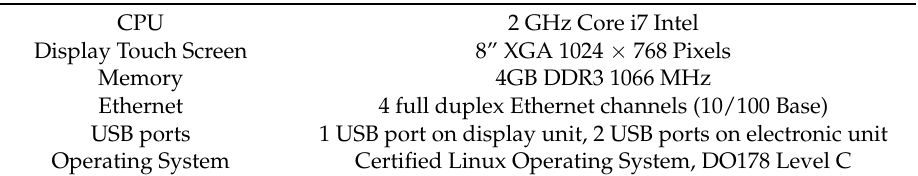
Table A1. Astronautics’ NEXIS EFB